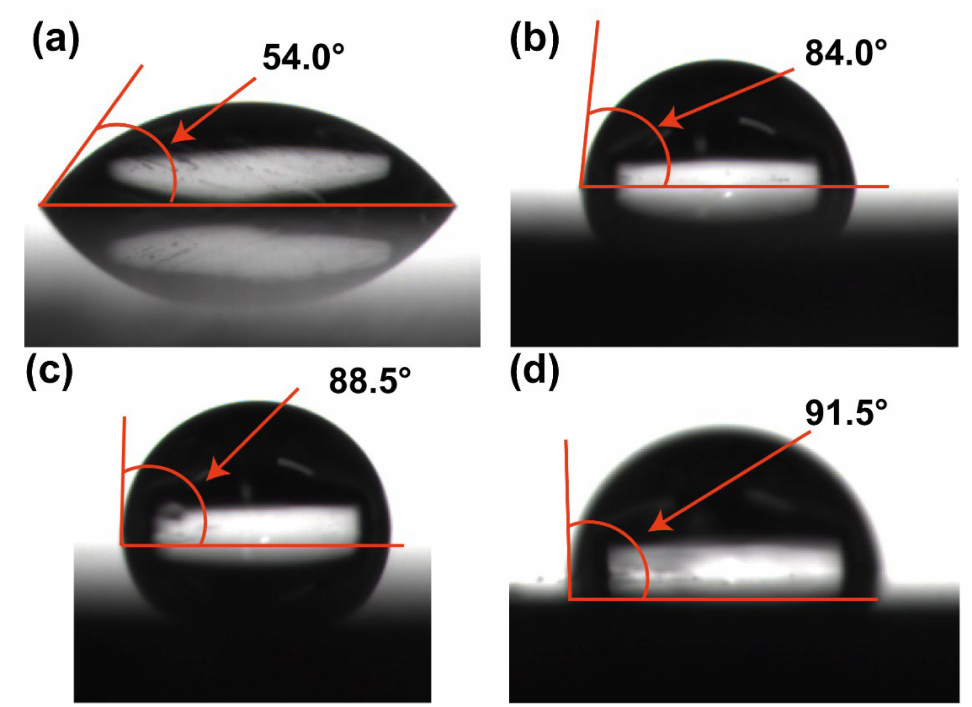
Figure 8. Photographs of water droplet on ( a ) SS316L, ( b ) Sample 3, ( c ) Sample 4, and ( d ) Sample 5.